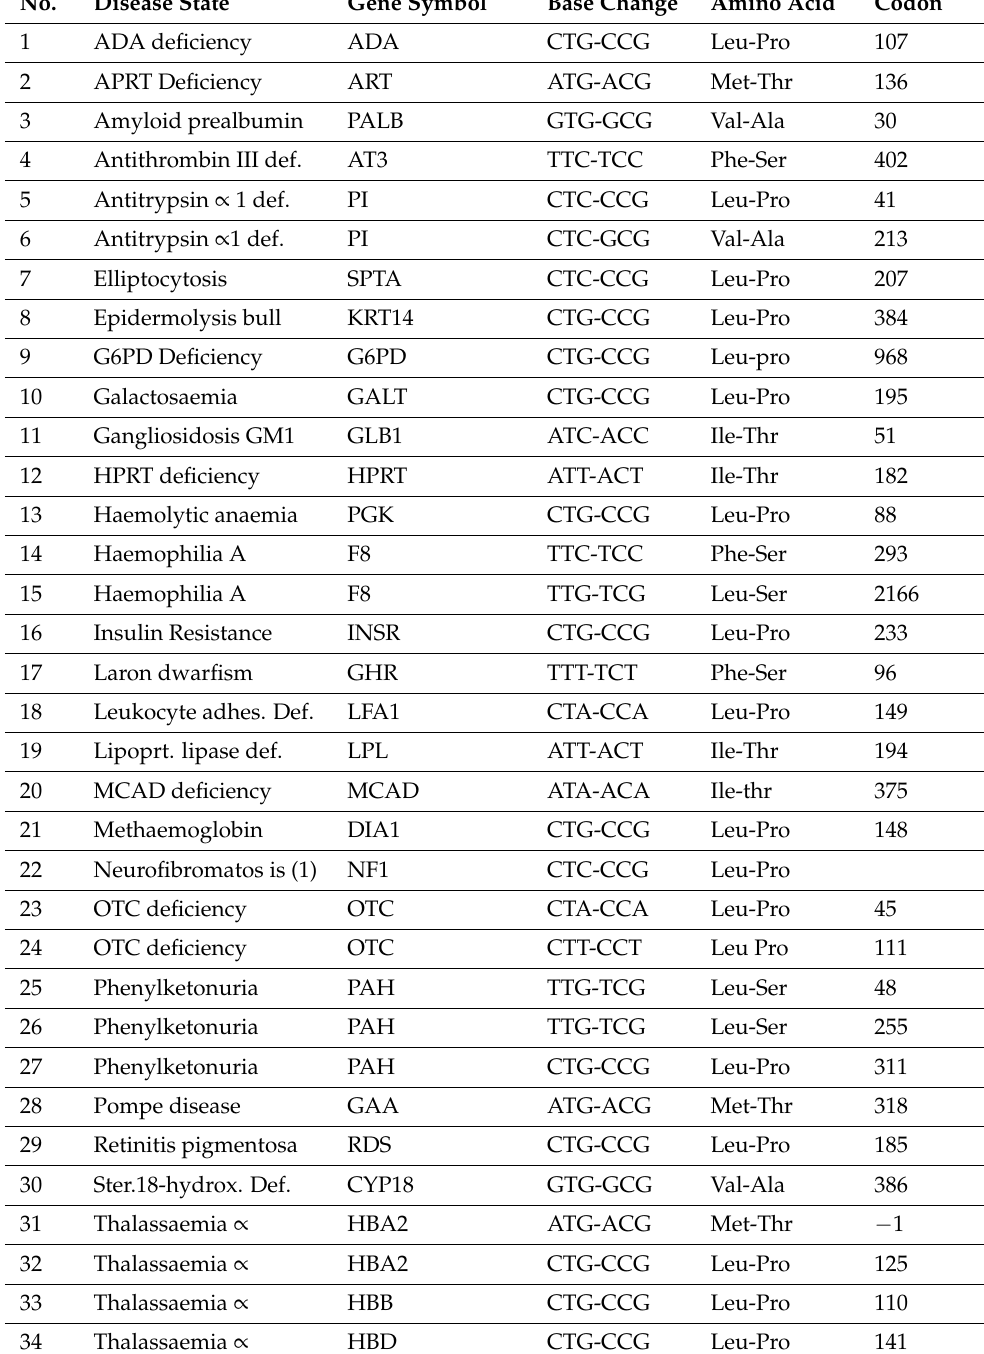
Table 1. Diseases caused by T to C